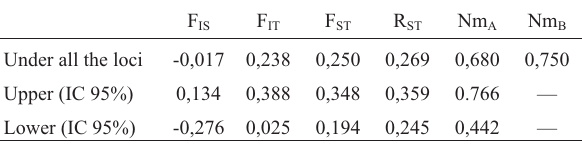
Table 6 - Wright’s F statistic’s, R ST and the number of migrants per generation (Nm) for ten natural Eugenia dysenterica populations. Confidence interval of 95% probability based on 10,000 bootstraps.